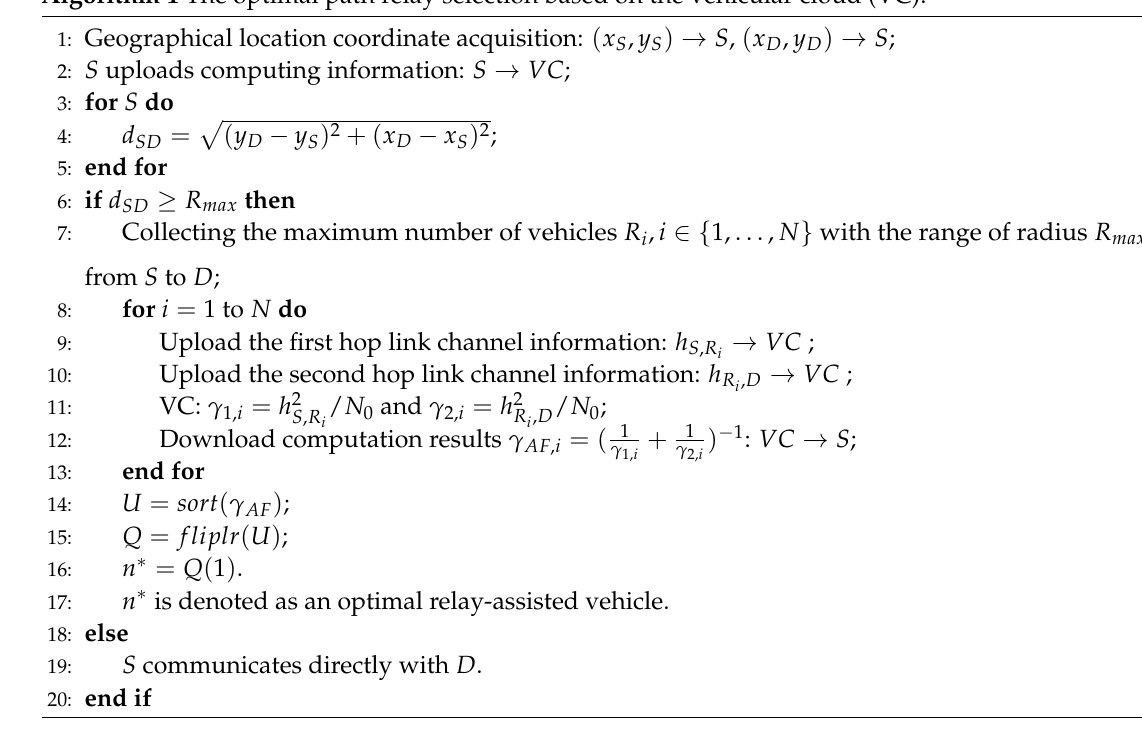
Algorithm 1 The optimal path relay selection based on the vehicular cloud